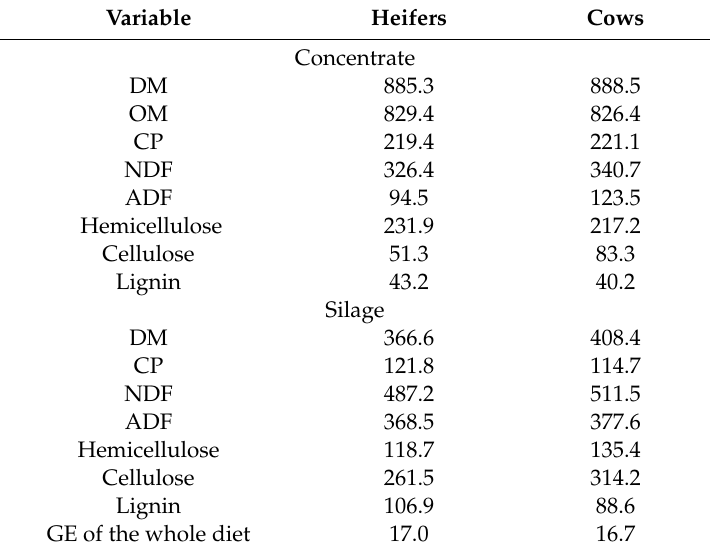
Table 2. Compositions of the silage and concentrate used in the experiment in g kg − 1 DM determined by chemical